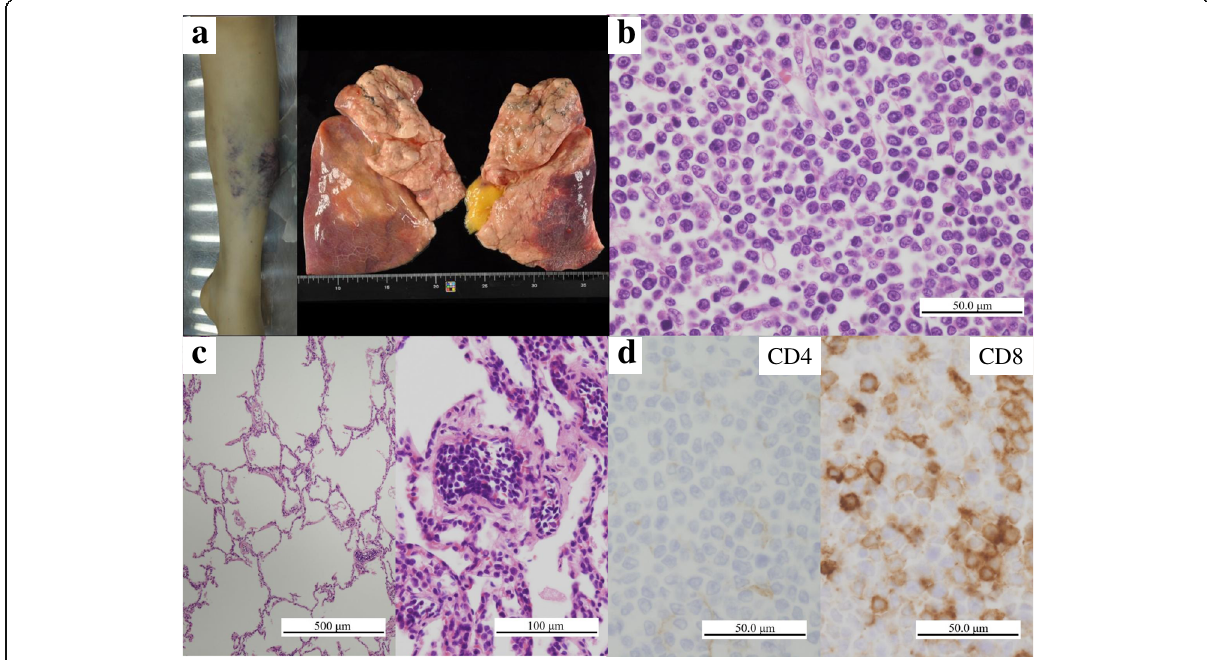
Fig. 2 The findings of the skin of lower leg, lung, and right inguinal lymph node at autopsy. ( a ) Purpuric nodules were seen on the bilateral lower leg (left). The lower lobes of the bilateral lungs were congested (right). ( b ) Lymphoma cells with rhomboidal or round nuclei were observed to have diffusely infiltrated into the lymph node. ( c ) Although the alveoli were filled with air (left), the pulmonary alveolar septa and capillary vessels were filled with atypical lymphocytes (right). Bar = 500 μ m (H&E staining) (original magnification: × 40) (left). Bar = 100 μ m (H&E staining) (original magnification: × 200) (right). ( d ) Immunohistochemistry revealed that the lymphoma cells that had infiltrated the lymph node were negative for CD4 but positive for CD8. Bar = 50 μ m (original magnification: ×